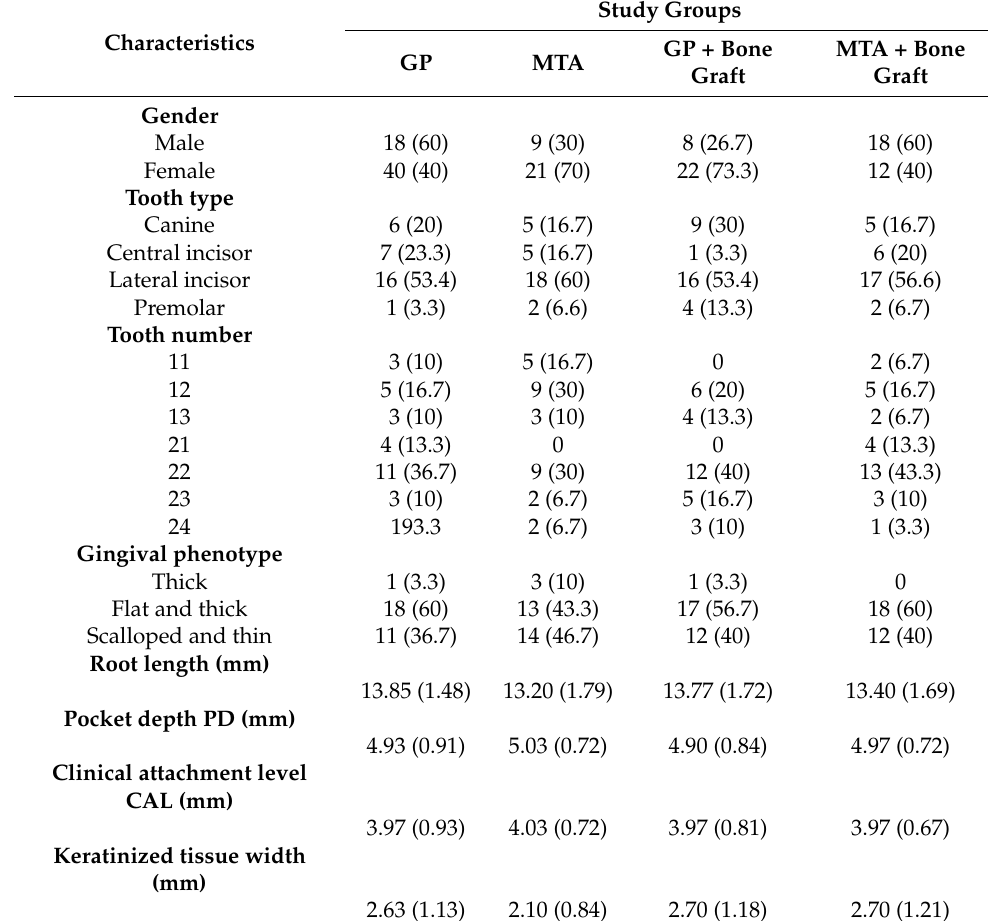
Table 2. Baseline characteristics of study subjects across the 4 study groups.